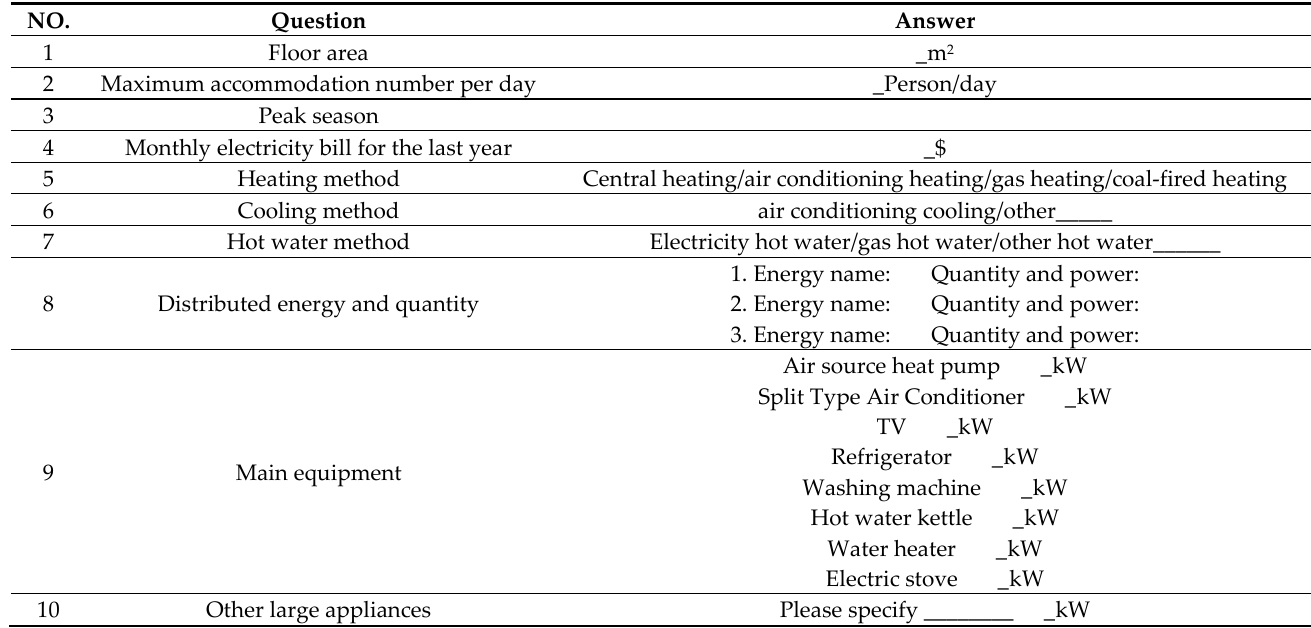
Table 1. Questionnaire on the energy consumption behavior of home